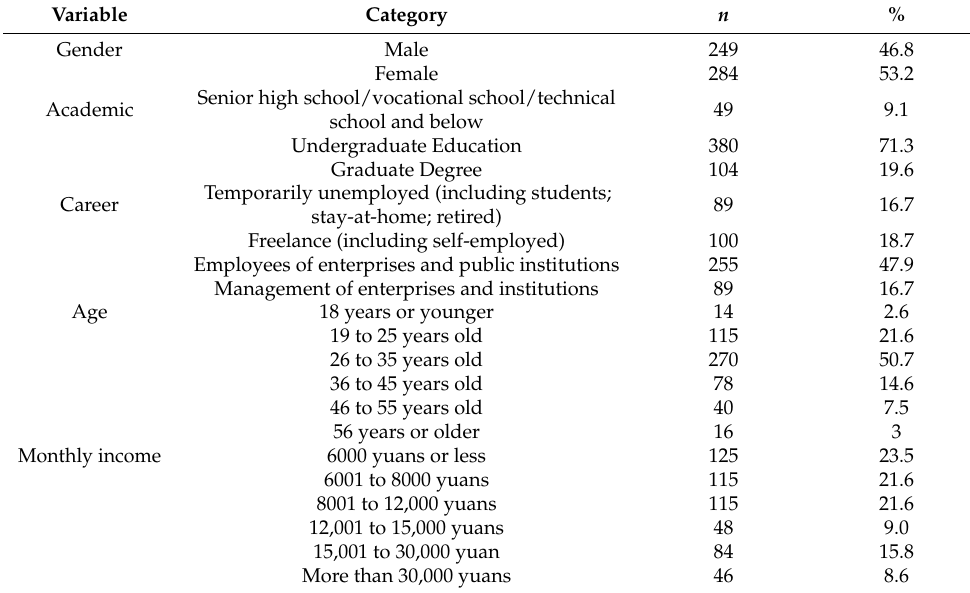
Table 2. Sociodemographic Characteristics of Research Participants ( N =